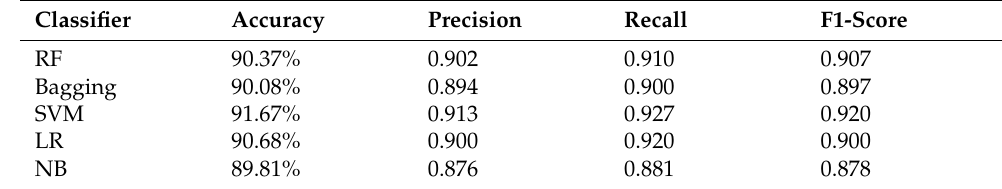
Table 17. Experiments with ML models and concatenated features on Arab TextBlob